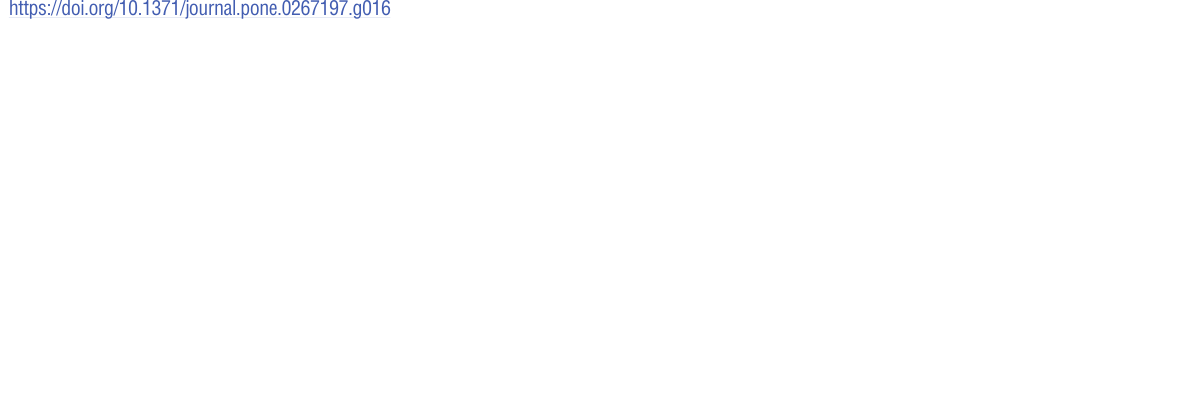
PLOS ONE | https://doi.org/10.1371/journal.pone.0267197 May 2, 2022 19 /